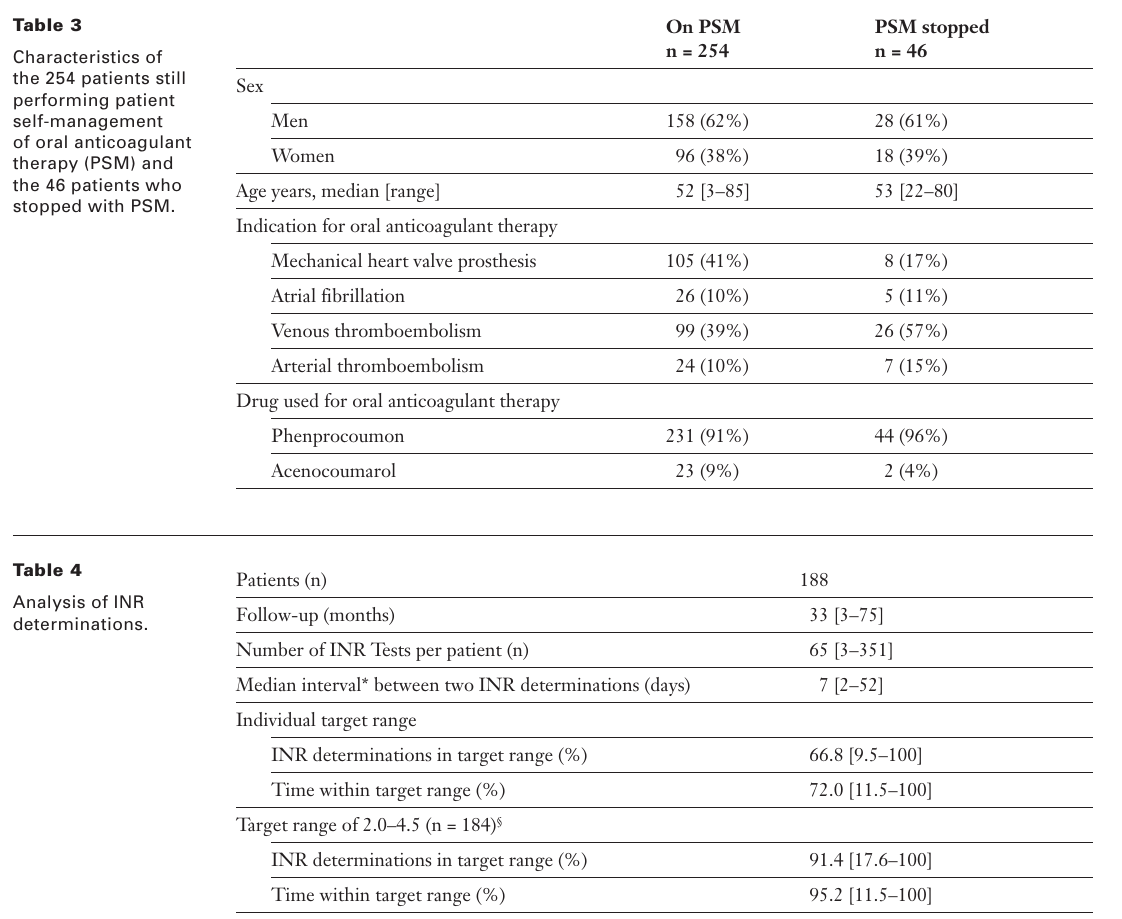
Characteristics of the 254 patients still performing patient self-management of oral anticoagulant therapy (PSM) and the 46 patients who stopped with PSM.